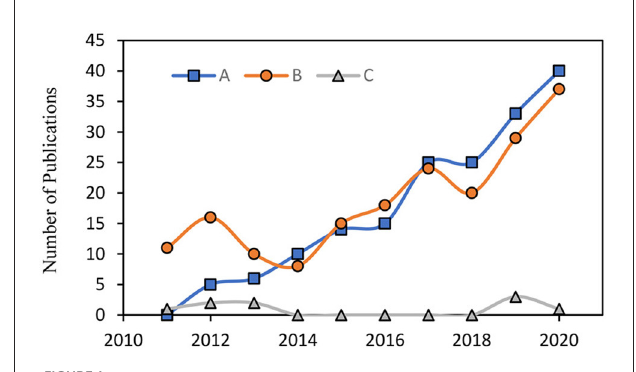
FIGURE1 The number of publication featuring (A) “marine bioactive compounds” + “combination” in Scopus. (B) “marine bioactive compounds” + “combination” in PubMed. (C) “natural marine bioactive compounds” + “combination” in Scopus & PubMed & Google